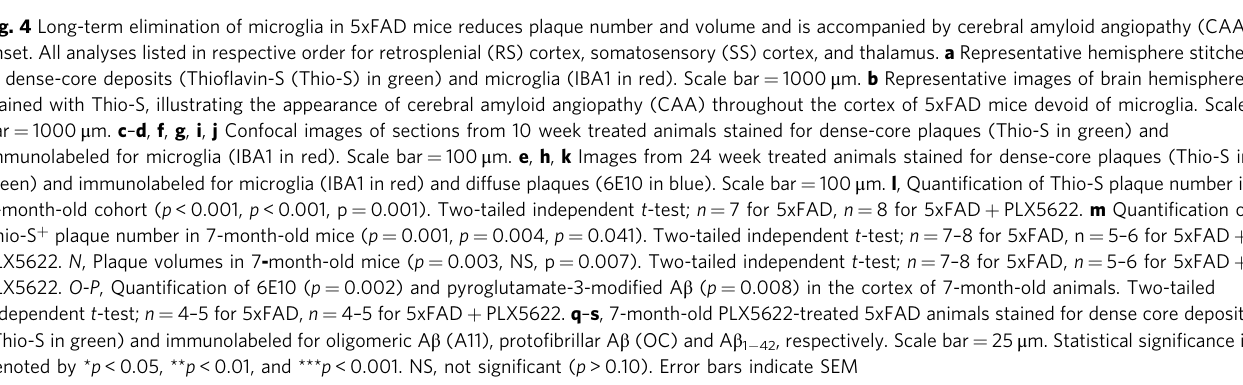
Fig. 4 Long-term elimination of microglia in 5xFAD mice reduces plaque number and volume and is accompanied by cerebral amyloid angiopathy (CAA) onset. All analyses listed in respective order for retrosplenial (RS) cortex, somatosensory (SS) cortex, and thalamus. a Representative hemisphere stitches of dense-core deposits (Thio fl avin-S (Thio-S) in green) and microglia (IBA1 in red). Scale bar = 1000 μ m. b Representative images of brain hemispheres stained with Thio-S, illustrating the appearance of cerebral amyloid angiopathy (CAA) throughout the cortex of 5xFAD mice devoid of microglia. Scale bar = 1000 μ m. c – d , f , g , i , j Confocal images of sections from 10 week treated animals stained for dense-core plaques (Thio-S in green) and immunolabeled for microglia (IBA1 in red). Scale bar = 100 μ m. e , h , k Images from 24 week treated animals stained for dense-core plaques (Thio-S in green) and immunolabeled for microglia (IBA1 in red) and diffuse plaques (6E10 in blue). Scale bar = 100 μ m. l , Quanti fi cation of Thio-S plaque number